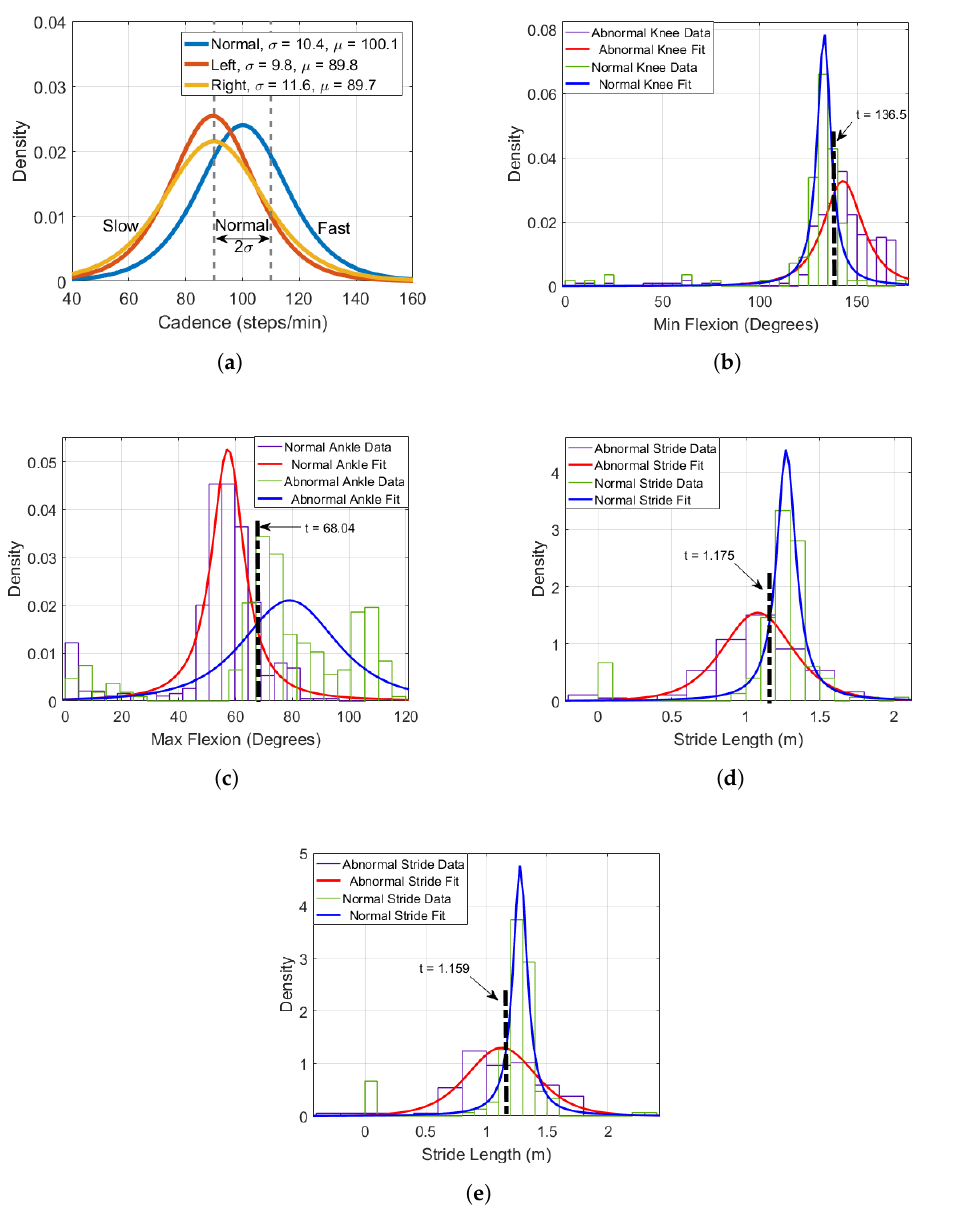
Figure 6. PDFs of features such as: ( a ) cadence; ( b ) minimum knee flexion; ( c ) maximum ankle flexion; ( d ) left stride length; and ( e ) right stride length, selected for the proposed